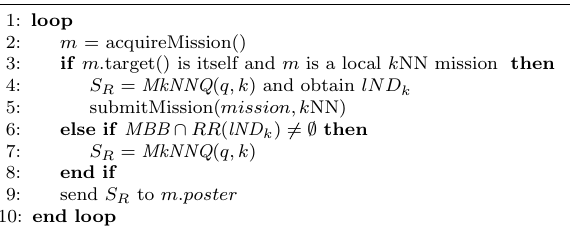
Algorithm 9 k NN Subscribing